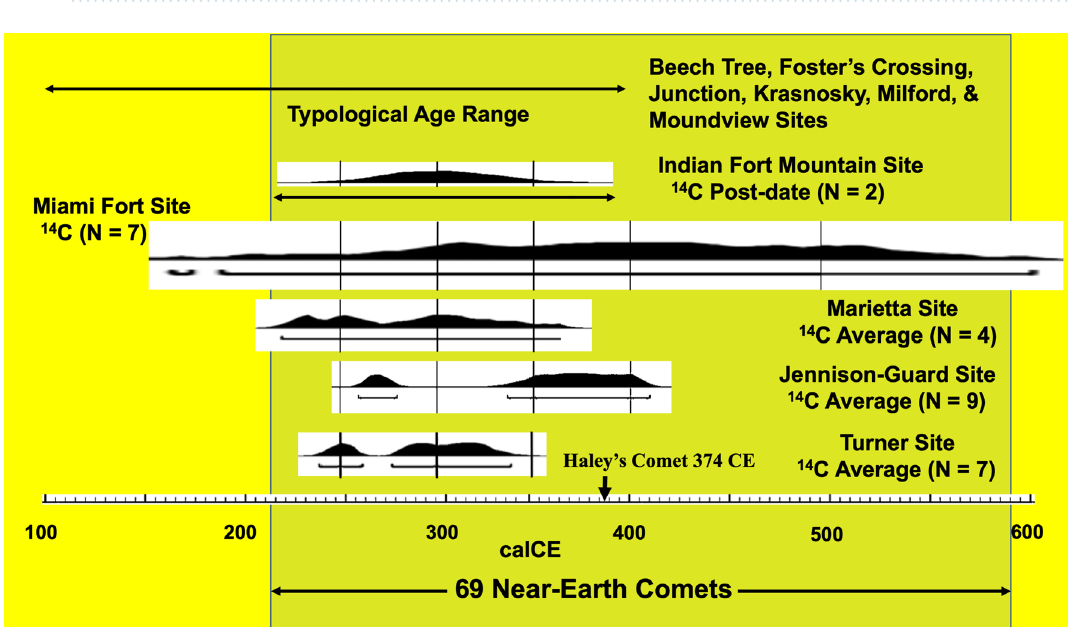
Figure 21. Typological age range and Bayesian adjustments of the radiocarbon ages averages for the Hopewell archaeological study sites using the IntCal20 calibration curve in the OxCal 4.4 computer program relative to the timing of 69 near-Earth comets. Kenneth Barnett Tankersley used Microsoft PowerPoint for Mac Version 16.41 (www. micro soft. com) to create this